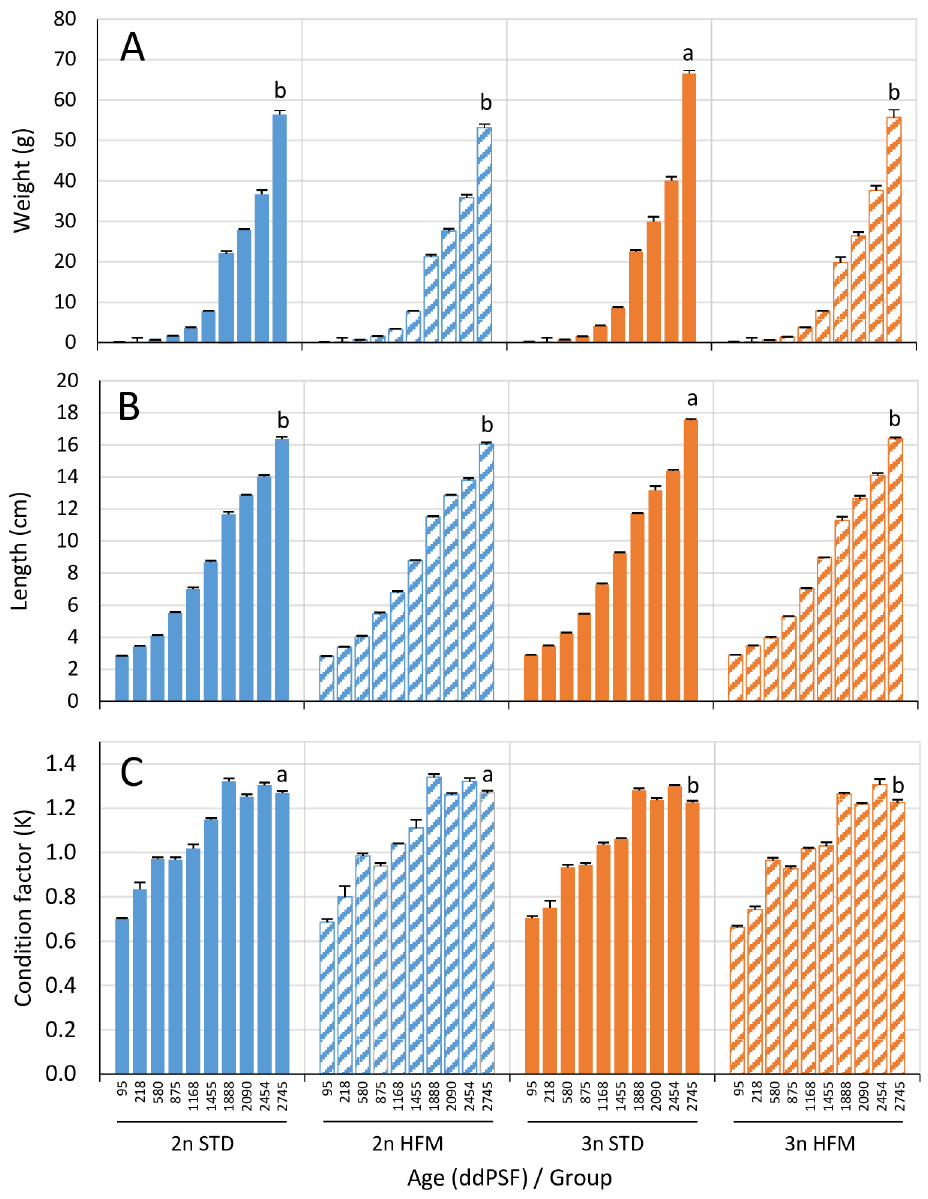
Fig 4. Fish growth from individual measurements. (A) Body weight, (B) length and (C) condition factor of diploid (2n) and triploid (3n) Atlantic salmon, Salmo salar , fed fish meal (STD) and hydrolyzed fish protein (HFM) diets measured at ten sampling points (see Fig 1: 95–2745 ddPSF). Results from statistical comparisons among groups are shown for the last sampling point (2745 ddPSF) (for full overview see Supplementary material: S2 Table). Different letters denote significant differences ( P < 0.05). Data are presented as means ± SEM (n =